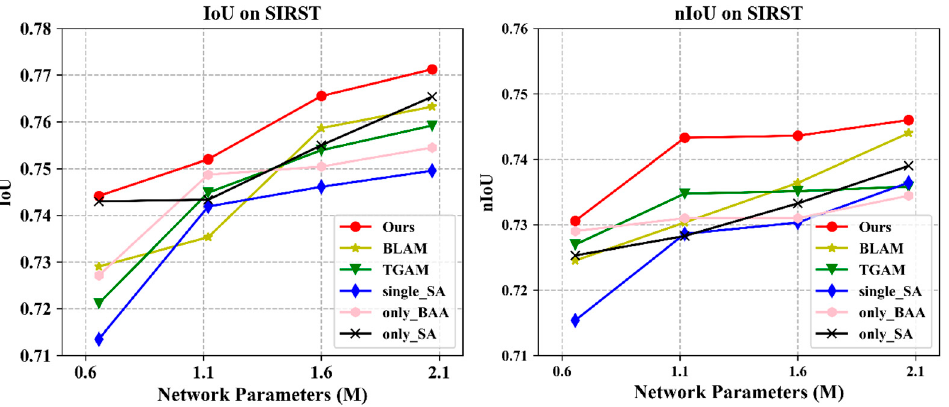
Figure 7. IoU/nIoU comparison with other cross-layer modulation schemes with U-Net as the host networks.